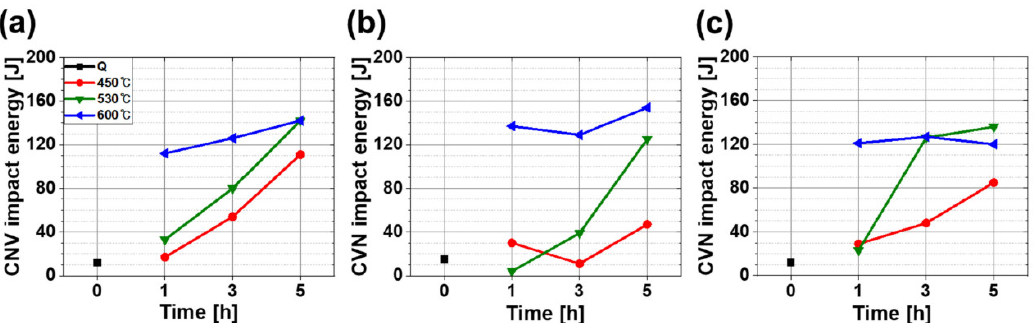
Figure 11. CVN impact energy of ( a ) FC (−10.6 °C/s), ( b ) MC (−4.6 °C/s), ( c ) SC (−2.5 °C/s) specimens according to the tempering conditions. Colors indicate tempering conditions: black, red, green and blue mean quenching, 450, 530 and 600 °C, respectively.